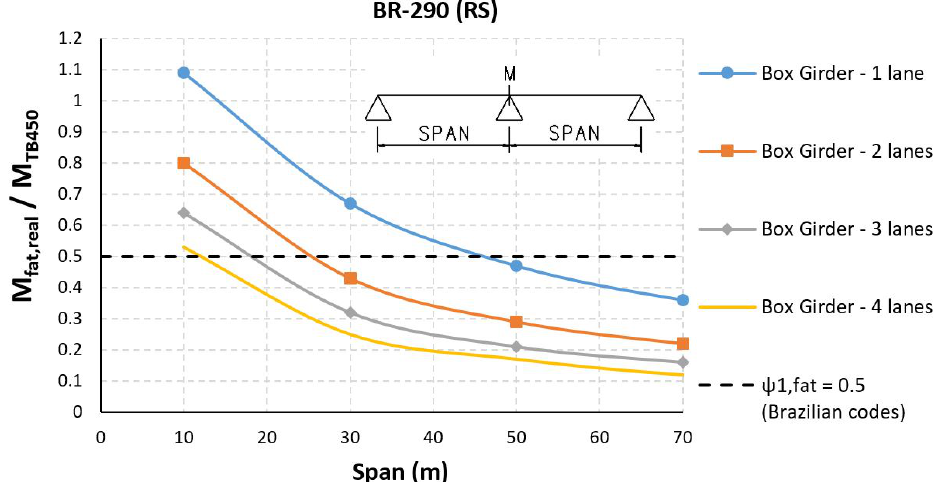
Figure 18. Bias factors for bending moment at support in continuous box-girder bridges – BR-290